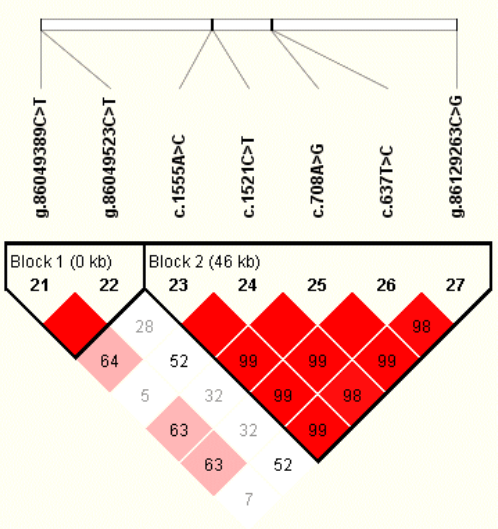
Figure 1. Linkage disequilibrium estimated among the SNPs in LPIN1 (D ′ = 0.98–1.00). Seven SNPs of LPIN1 formed two haplotype blocks. The values in boxes are pairwise SNP correlations (D ′ ), while bright red boxes without numbers indicate complete LD (D ′ = 1). The blocks indicate haplotype blocks and the text above the horizontal numbers is the SNP names.